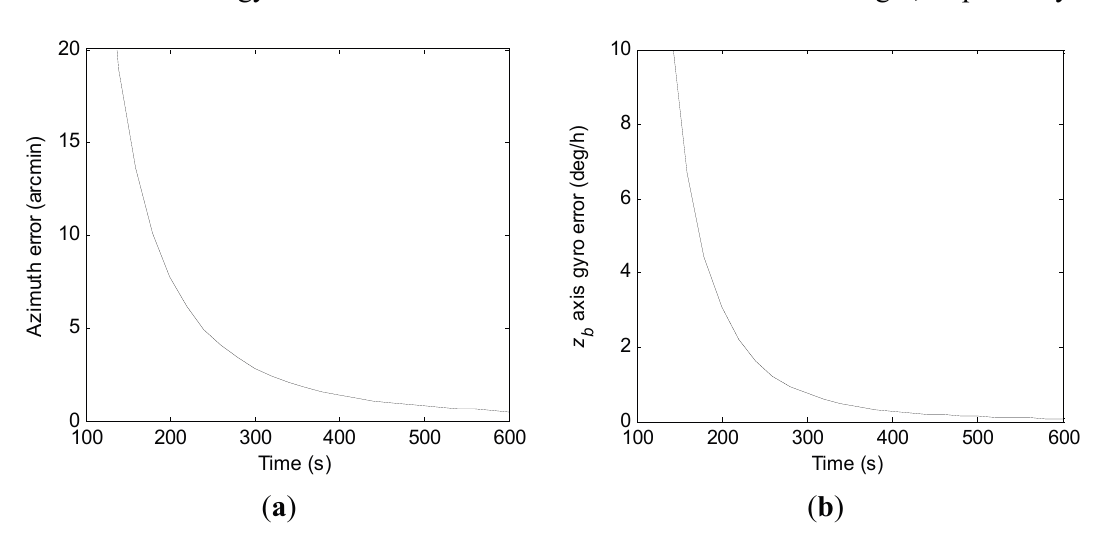
Figure 8. Convergence curves of the azimuth error and the z b axis gyro error within 600 s by the conventional KF scheme. ( a ) Azimuth error; ( b ) z b axis gyro erro. Convergence curves of the azimuth error and the z b axis gyro error with error covariance computations by Equation (21) within 600 s for the constrained KF scheme are shown in Figure